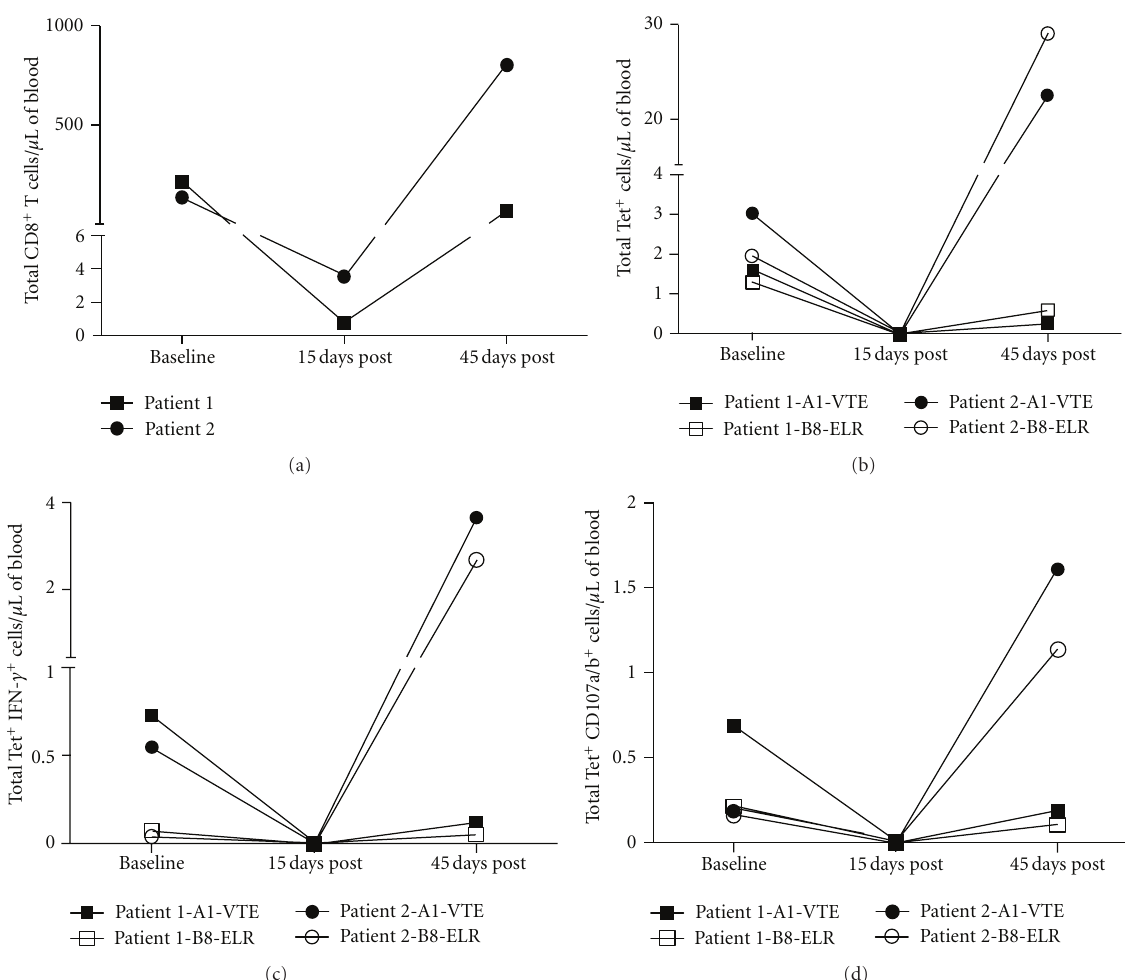
Figure 2: Results of CMV-related immune competence assays in two patients treated with autologous HSCT. Absolute counts of CD8 + T cells (a); CMV tetramer-specific CD8 + T cells (Tet + ) (b); Tet + IFN- γ -producing cells (c); Tet + CD107a/b + cells (d) are shown per microliter of blood. Results are presented for CMV-specific HLA-A ∗ 01:01 tetramer (A1-VTE), and HLA-B ∗ 08:01 tetramer (B8-ELR). Baseline counts correspond to results before